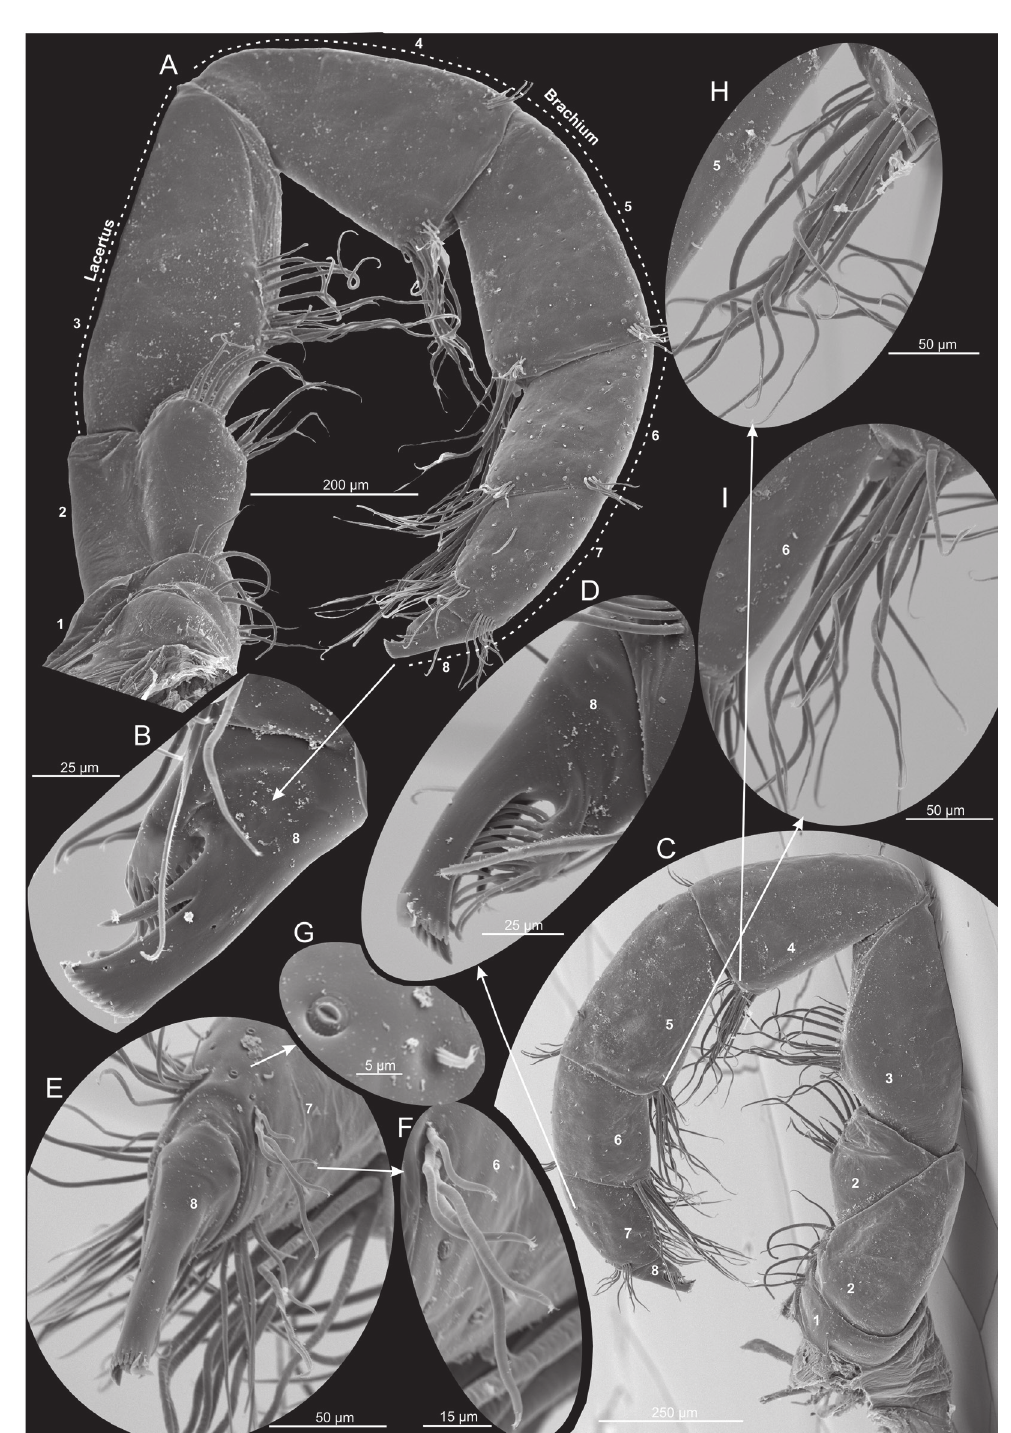
Fig. 8. Xibalbanus cozumelensis sp. nov., paratype (ZMUC-CRU-4792), maxilliped (mxp), left side, scanning electron microscopy. A . Complete mxp from anterior. B . Close-up of terminal claw-complex from anterior (segment 8). C . Complete mxp from posterior. D . Close-up of terminal claw-complex from posterior (segment 8). E . Close-up of terminal claw-complex from lateral (segment 8). F . Close-up of small cluster of setae along distal margin of segment 7. G . Close-up of pore at close to latero-distal margin of segment 7. H . Close-up of cluster of setae at latero-distal corner of segment 4. I . Close-up of cluster of setae at latero-distal corner of segment